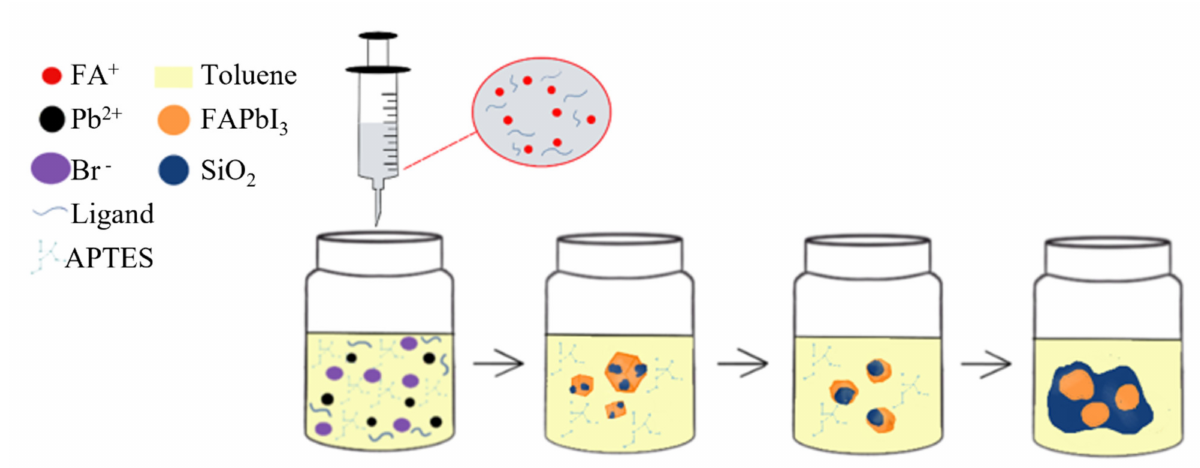
Figure 1. Schematic of the air-synthesis method for preparation of FAPbI 3 NCs. The APTES molecule provides Si–O bonds which generate the Si–O–Si ligands through hydrolysis and dehydration in the reaction to package PNPs. This protects PNPs from environmental factors [39–41]. Therefore, to verify Si–O–Si ligands on the surface of PNCs, a FTIR spectrum was used to prove the silica wrapping (Figure 2). The absorption peak at 914 and 1108 cm − 1 can be observed in the FAPbI 3 PNCs sample, which is attributed to Si–OH bonds caused by the hydrolysis condensation of APTES and asymmetrical Si-O-Si groups, respectively. These two peaks at 914 and 1108 cm − 1 indicate that APTES is well bonded to FAPbI 3 PNCs. In addition, there is a strong stretching vibration at 1710 cm − 1 due to C=N from FA + . The C–H stretching vibrations of CH 2 and CH 3 were detected from 2800 to 3000 cm − 1 [41–43].